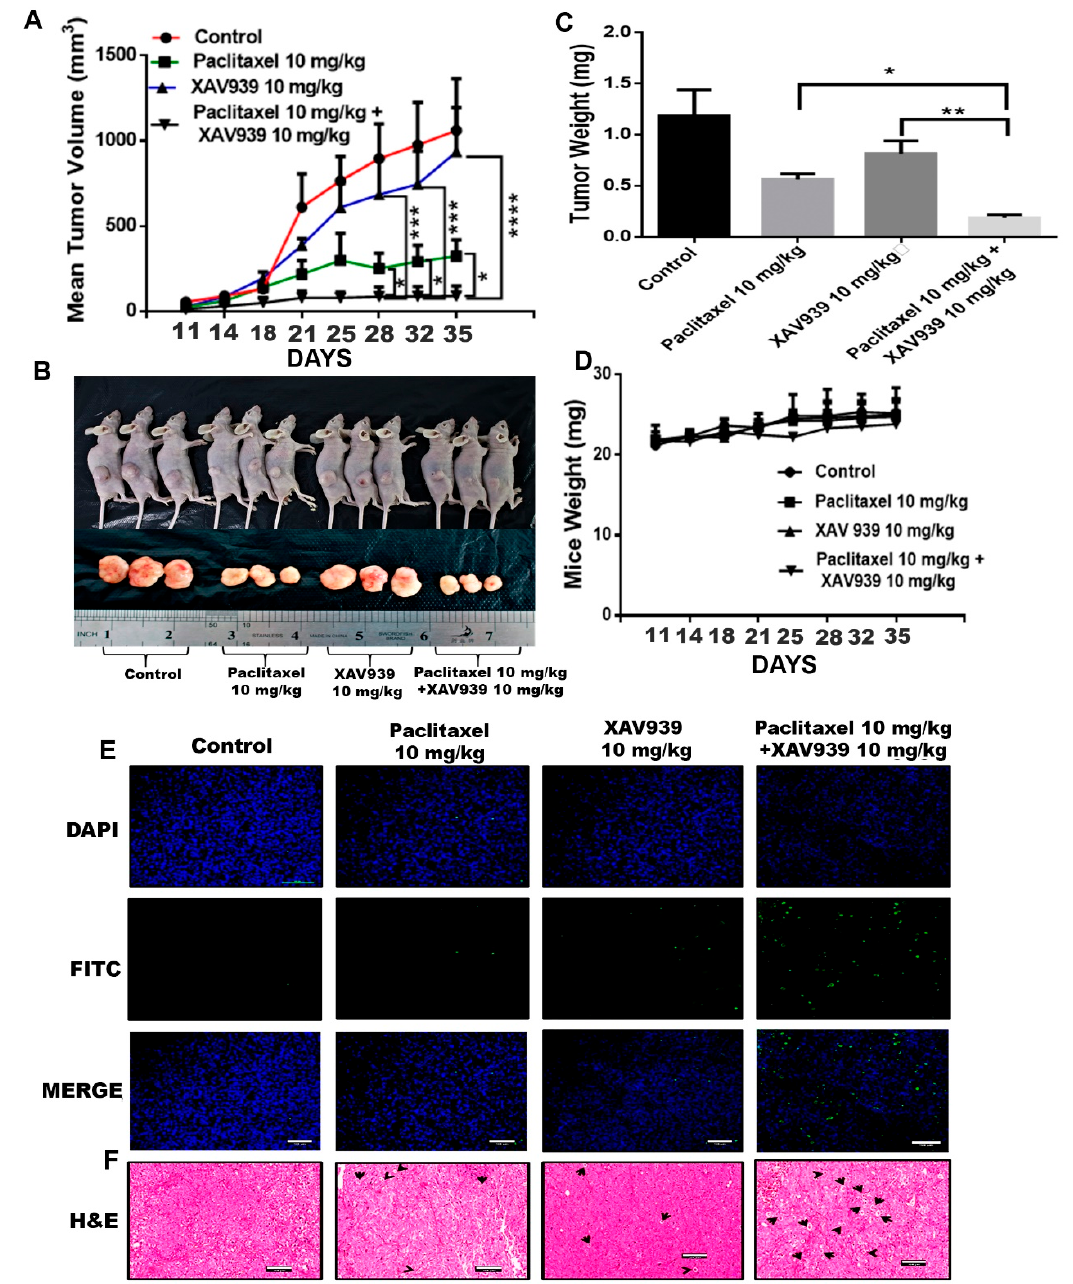
Figure 4. Combination treatment suppressed breast tumor growth by inducing apoptosis of tumor cells in an in vivo mouse model. MDA-MB-231-xenografted tumors were generated in BALB / c nude mice, and paclitaxel (10 mg / kg), XAV939 (10 mg / kg), and a combination of paclitaxel + XAV939 (10 mg / kg + 10 mg / kg) were injected intraperitoneally (i.p.) twice a week for 4 weeks. ( A ) Mouse tumor volume was monitored twice a week. Results are presented as mean ± SD (n = 3. *: p < 0.05, ***: p < 0.005, ****: p < 0.0003 compared to each single treatment with paclitaxel and XAV939). ( B , C ) At designated time points, mice were sacrificed, and tumors were isolated, photographed, weighed, and analyzed., Results are expressed as mean mass of tumors (mean ± SD, n = 3; *: p < 0.05, **: p < 0.001, compared to each single treatment with paclitaxel or XAV939). ( D ) The mouse weight was measured twice a week. ( E) TUNEL assay was performed on the tumor section, and green dots represent the apoptotic cells. ( F ) H&E staining was performed on the tumor section, and black arrows indicate the apoptotic cells. Photographs were taken at a magnification of 20 × . Scale bar = 100 µm.